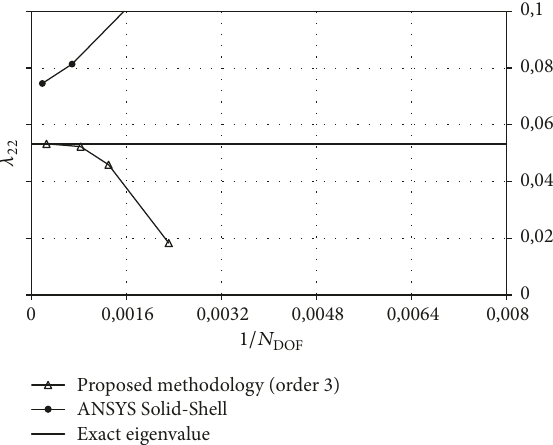
̂𝜆 1/𝑁 ℎ -con- 11 versus DOF (